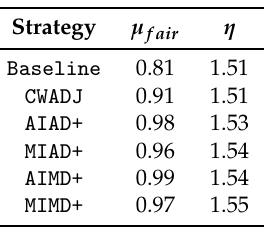
Table 4. Result comparisons.